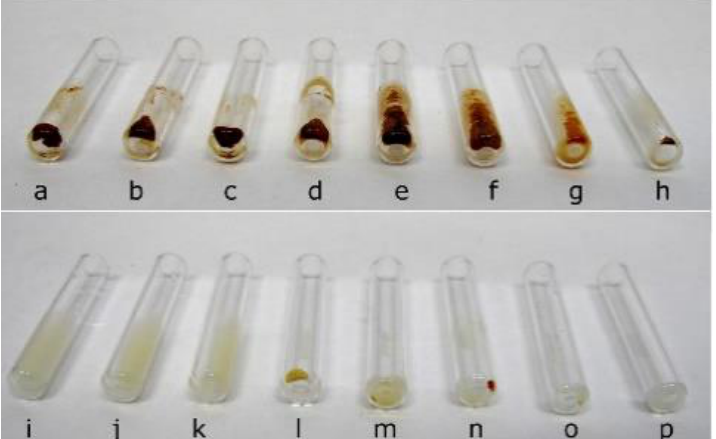
Figure 1. Precipitates obtained after adding chlorhexidine (CHX) to 5.25% sodium hypochlorite (NaOCl) ( a ); 2% ( w / v ) NaOCl ( b ); and 5.25% ( w / v ) NaOCl:H 2 O ( c–h ) mixed in the ratio of 1:1, 1:4, 1:9, 1:19, 1:49 and 1:99 ( v / v ), respectively, and precipitates obtained after adding alexidine dihydro- chloride (ALX) to 5.25% ( w / v ) NaOCl ( i ); 2% NaOCl ( j ); and 5.25% ( w / v ) NaOCl:H in the ratio of 1:1, 1:4, 1:9, 1:19, 1:49 and 1:99 ( v / v ), respectively.